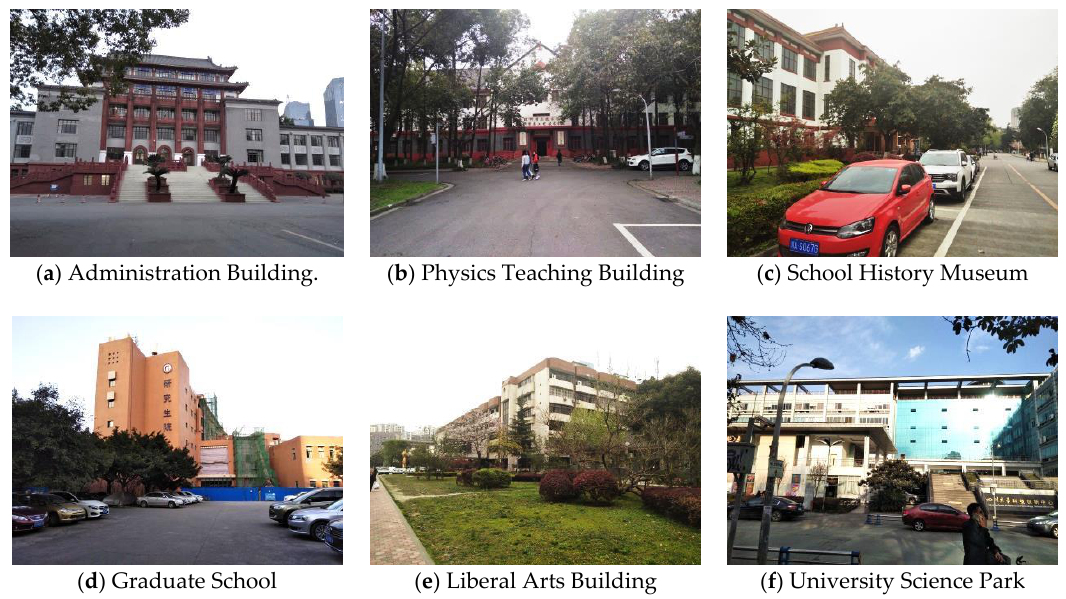
Figure 6. Campus architectures of Wangjiang Campus. ( a – c ) Campus architecture inheriting the characteristics of traditional residential buildings; ( d – f ) Modern architecture built in different ages.